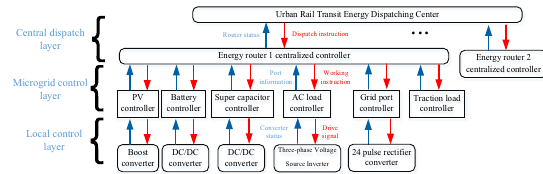
Fig. 2 Hierarchical coordinated control framework